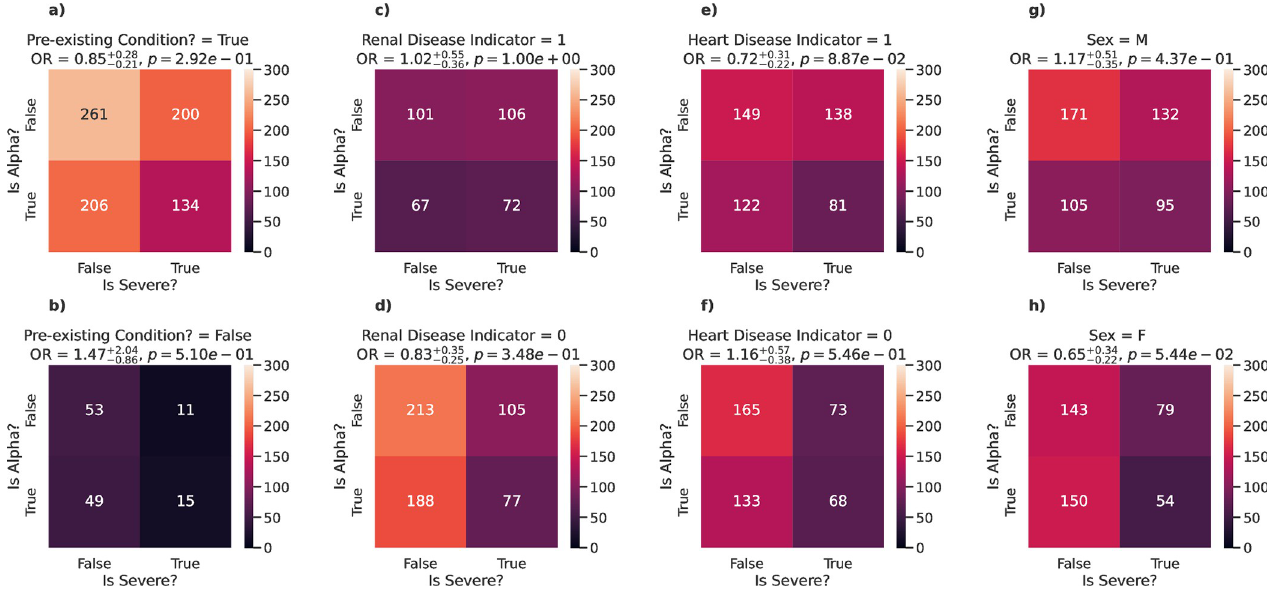
Fig 3. Effect of the Alpha variant on disease severity. Heatmaps exploring the changes in relative risk of severe outcome (death, ICU admission or intubation) for subpopulations within the data when comparing Alpha cases to non-Alpha cases. The subpopulations shown are based on those identified as being associated with disease severity. They are (in column order): Whether the patient has a pre-existing condition or not (a-b), whether the patient has renal disease or not (c-d), whether the patient has heart disease or not (e-f), and sex at birth (g-h). The odds ratio and p-values p between the classes are shown above each